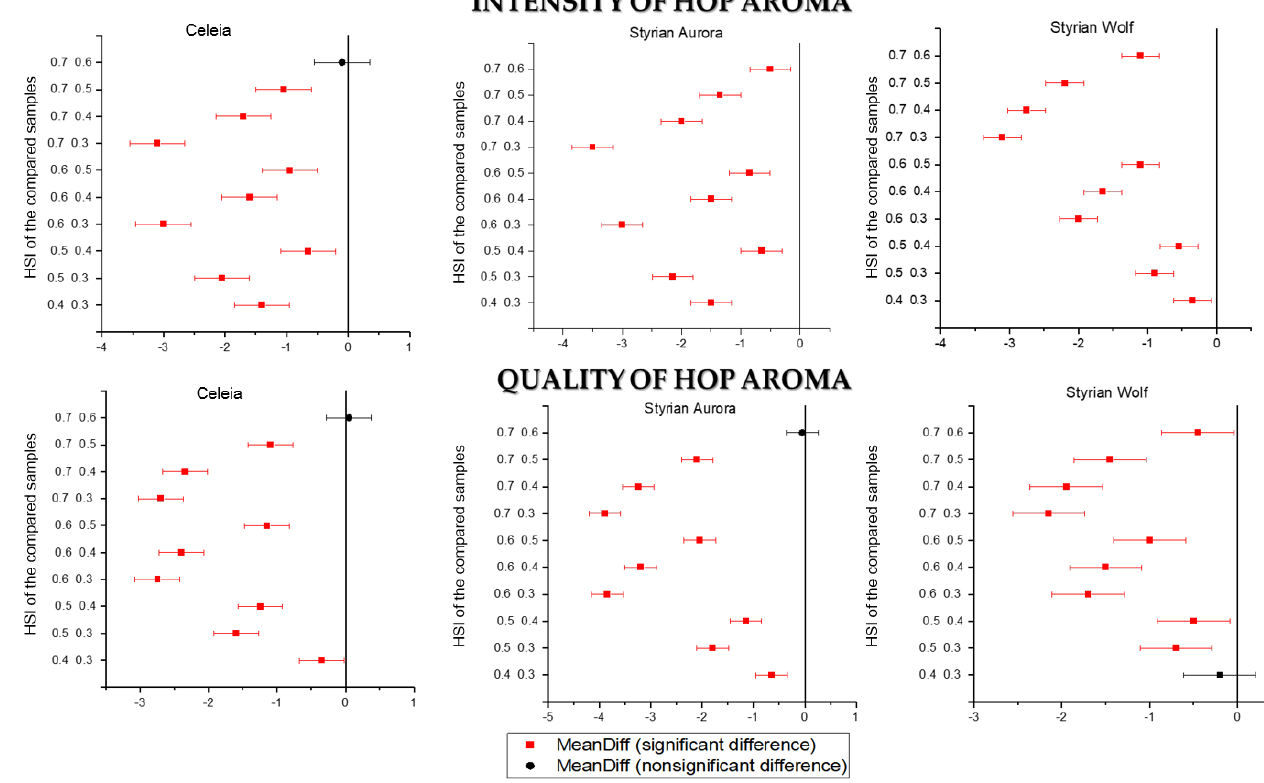
Figure 1. Tukey ’ s mean comparison plots for intensity and quality of hop aroma. Figure 1. Tukey’s mean comparison plots for intensity and quality of hop